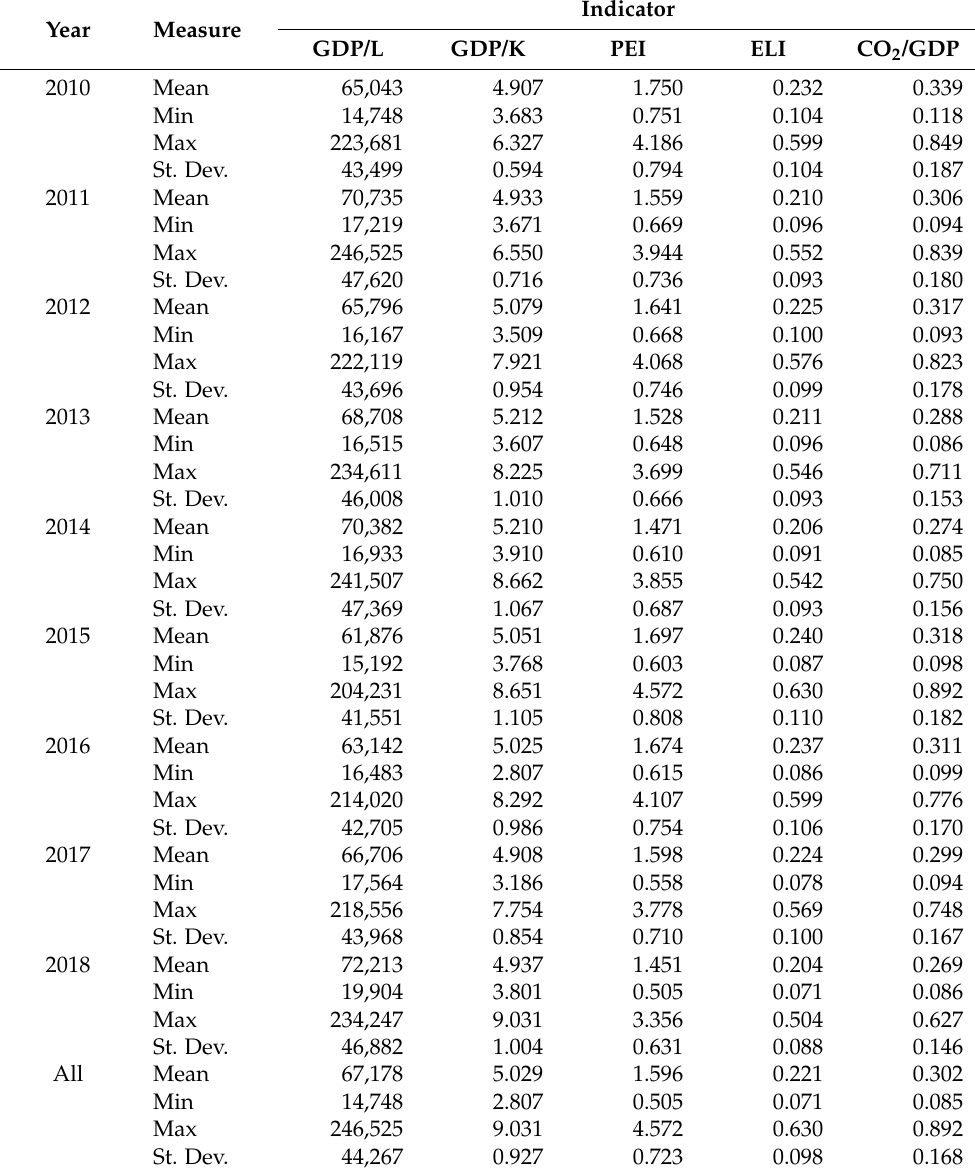
Table A4. Summary statistics for the derived variables over time.